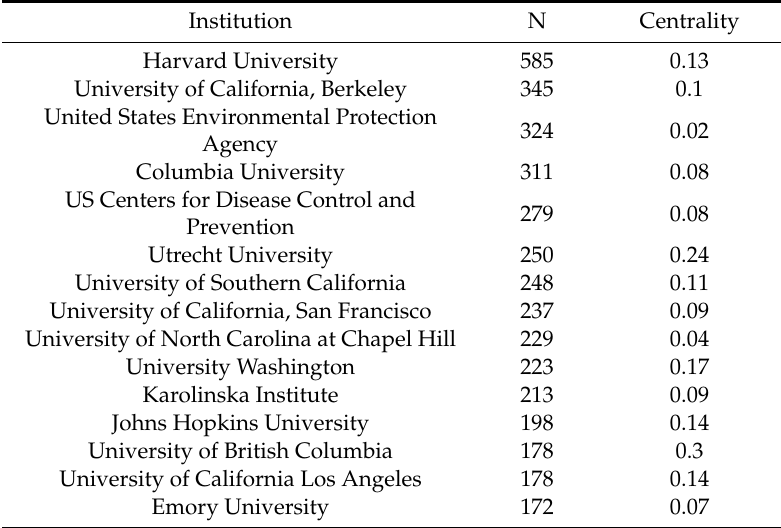
Table 2. The top fifteen institutes during the period 1999–2018.